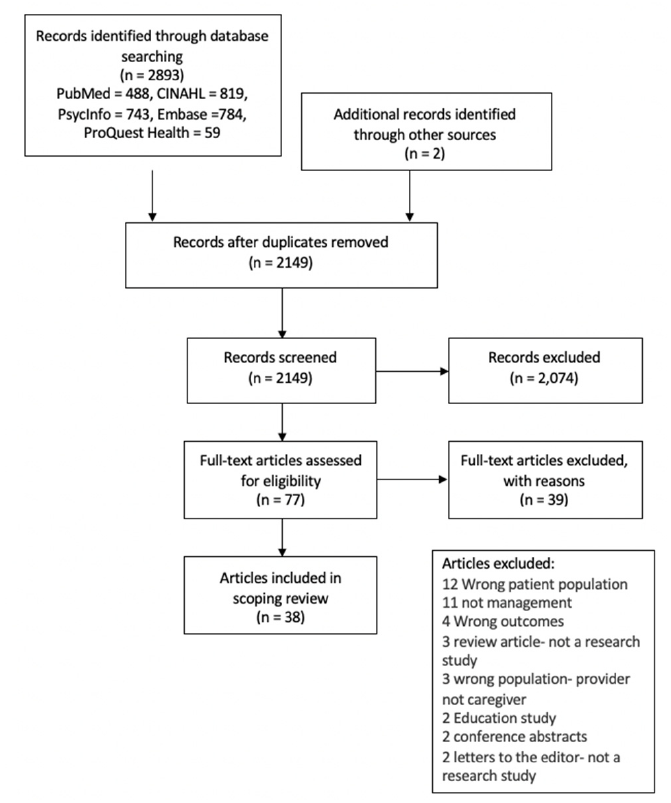
Figure 1. PRISMA Figure 1. PRISMA diagram.